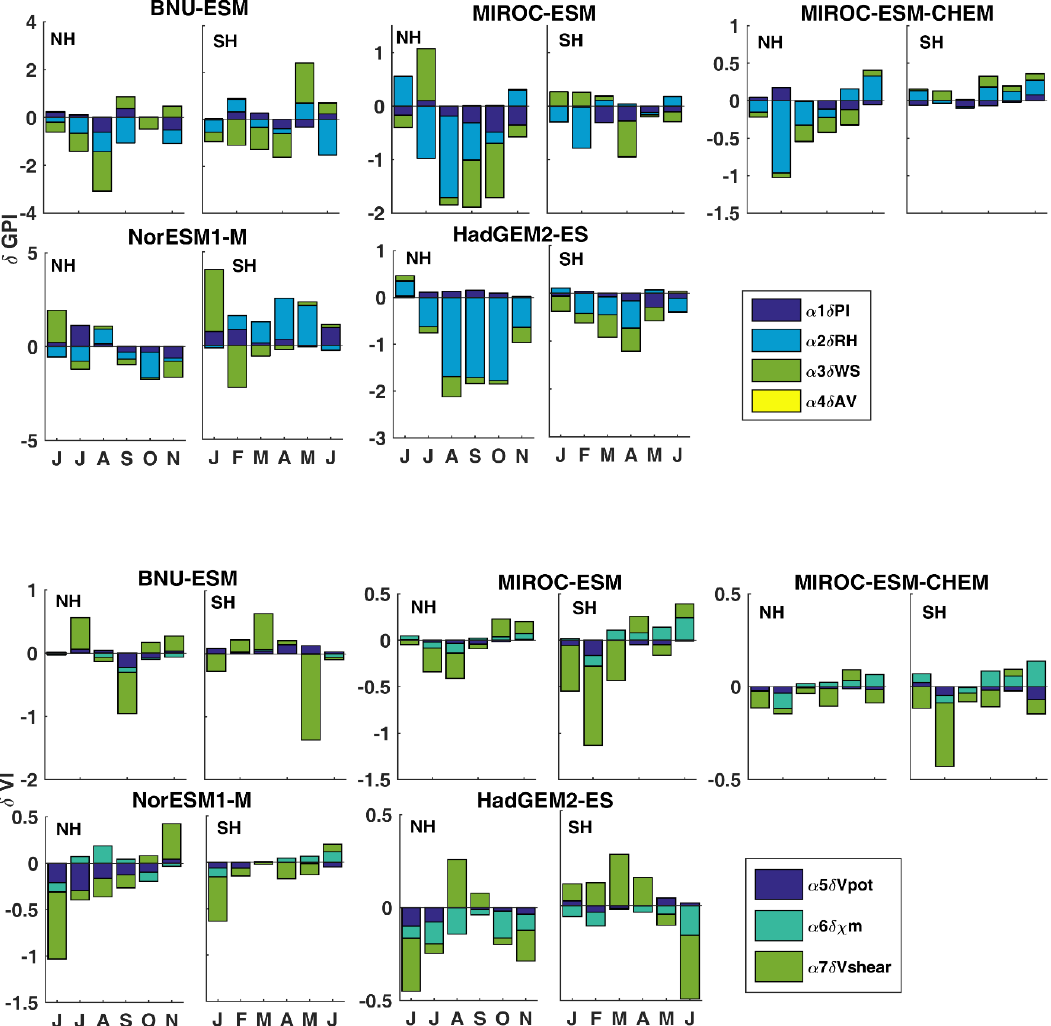
Figure 4. The mean month contribution of each variable to the difference (G4 − RCP4.5) for the years 2020–2069 in TC basins and TC season in GPI and